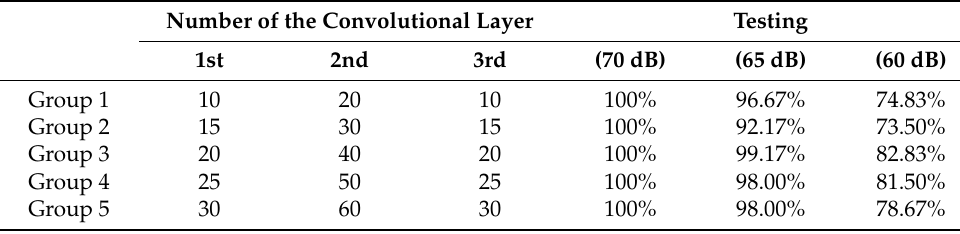
Table 3. Results of different filter numbers.